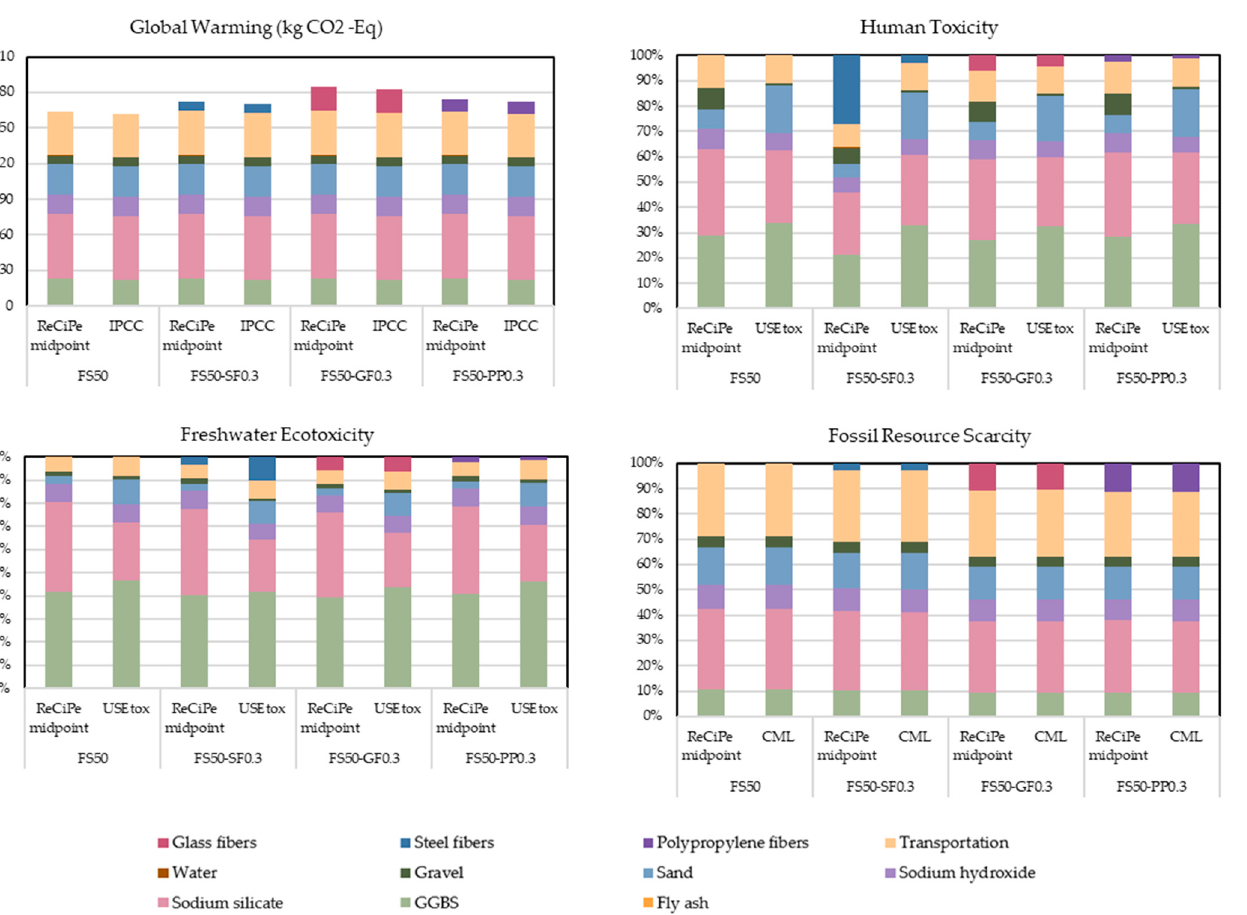
Figure 10. Comparison of ReCiPe midpoint assessment results with ILCD recommended methods.